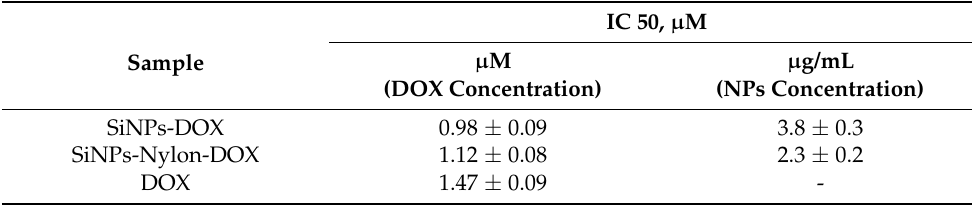
Table 4. The IC50 values of SiNPs-DOX and SiNPs-Nylon-DOX for the A549 cell line per DOX or nanoparticles concentration.